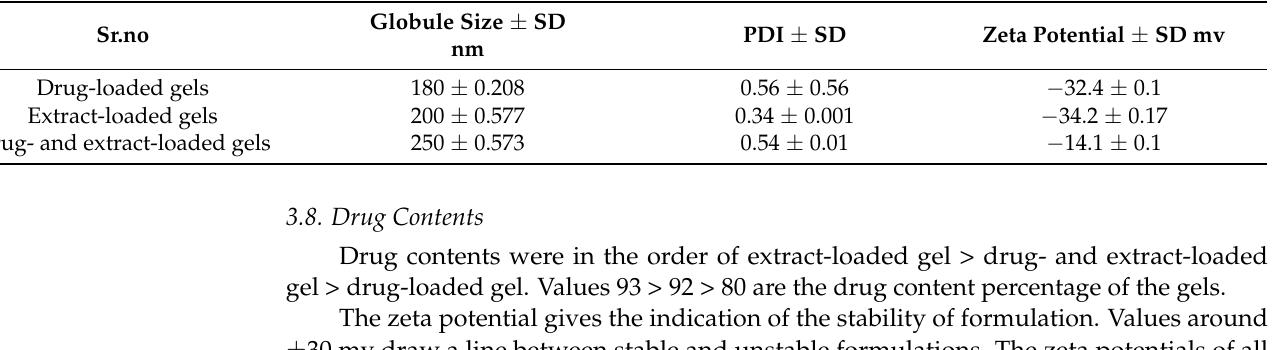
Table 3. Globule size, polydispersity index, and zeta potential of topical